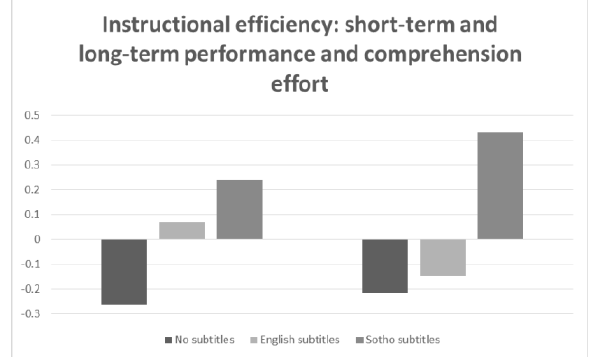
Figure 7. Instructional efficiency for performance and comprehension effort